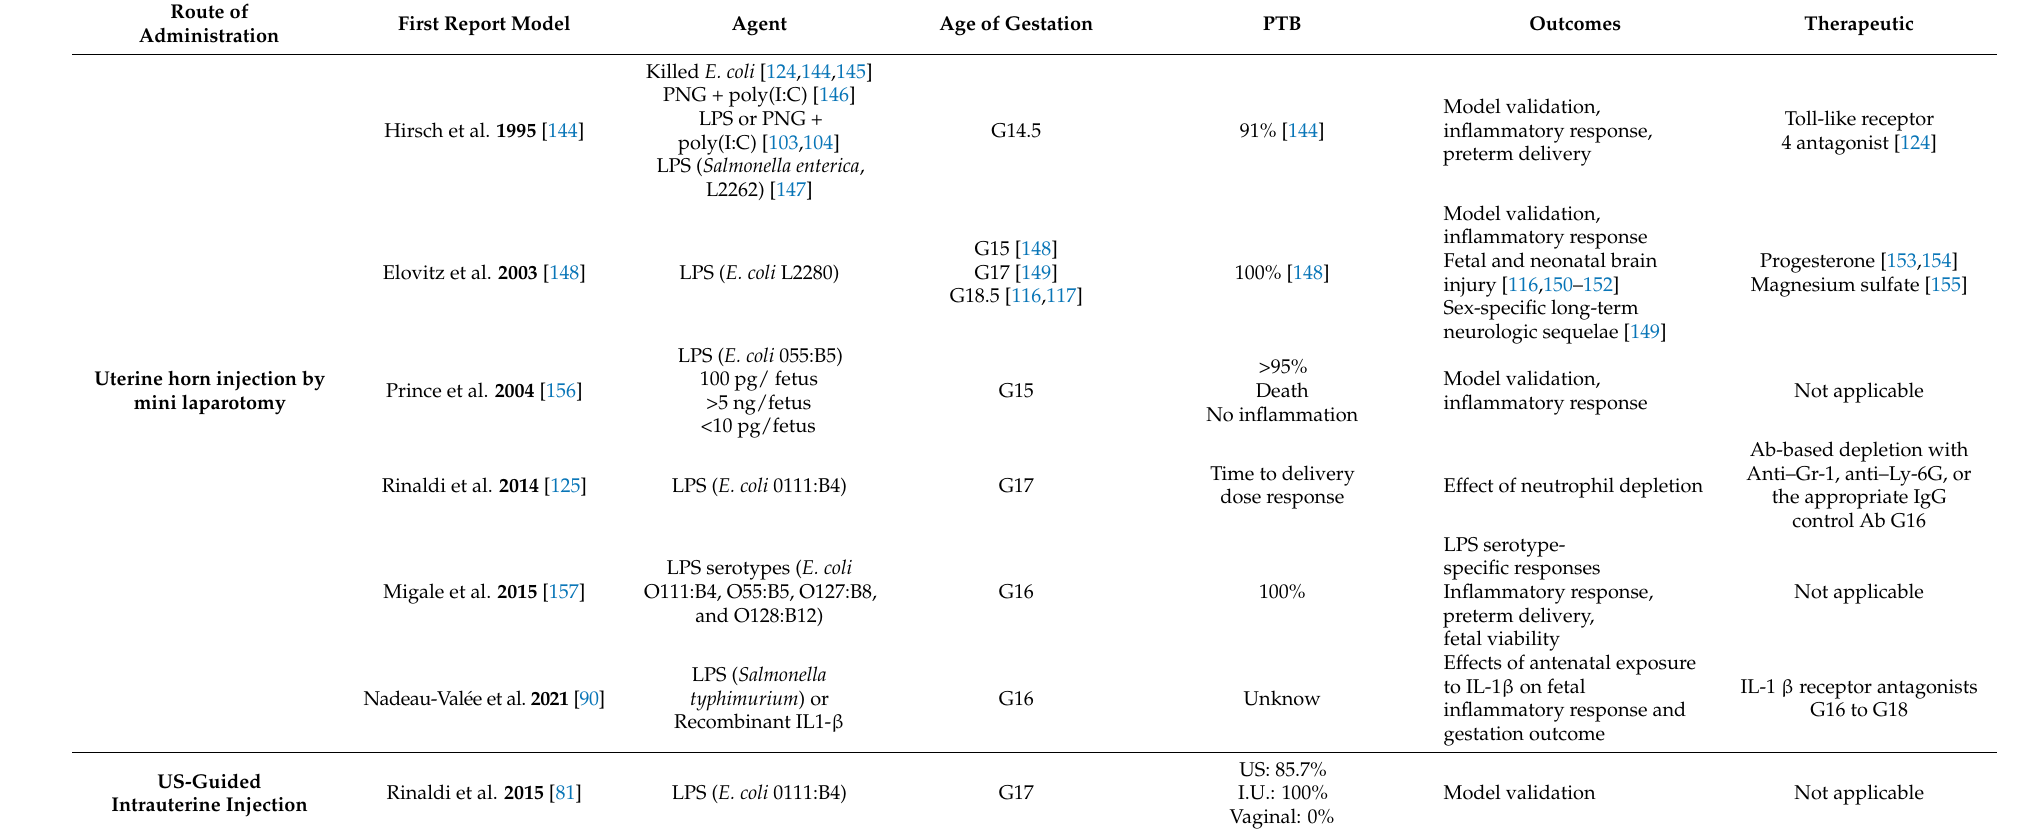
Table A1. Summary of mice models of acute